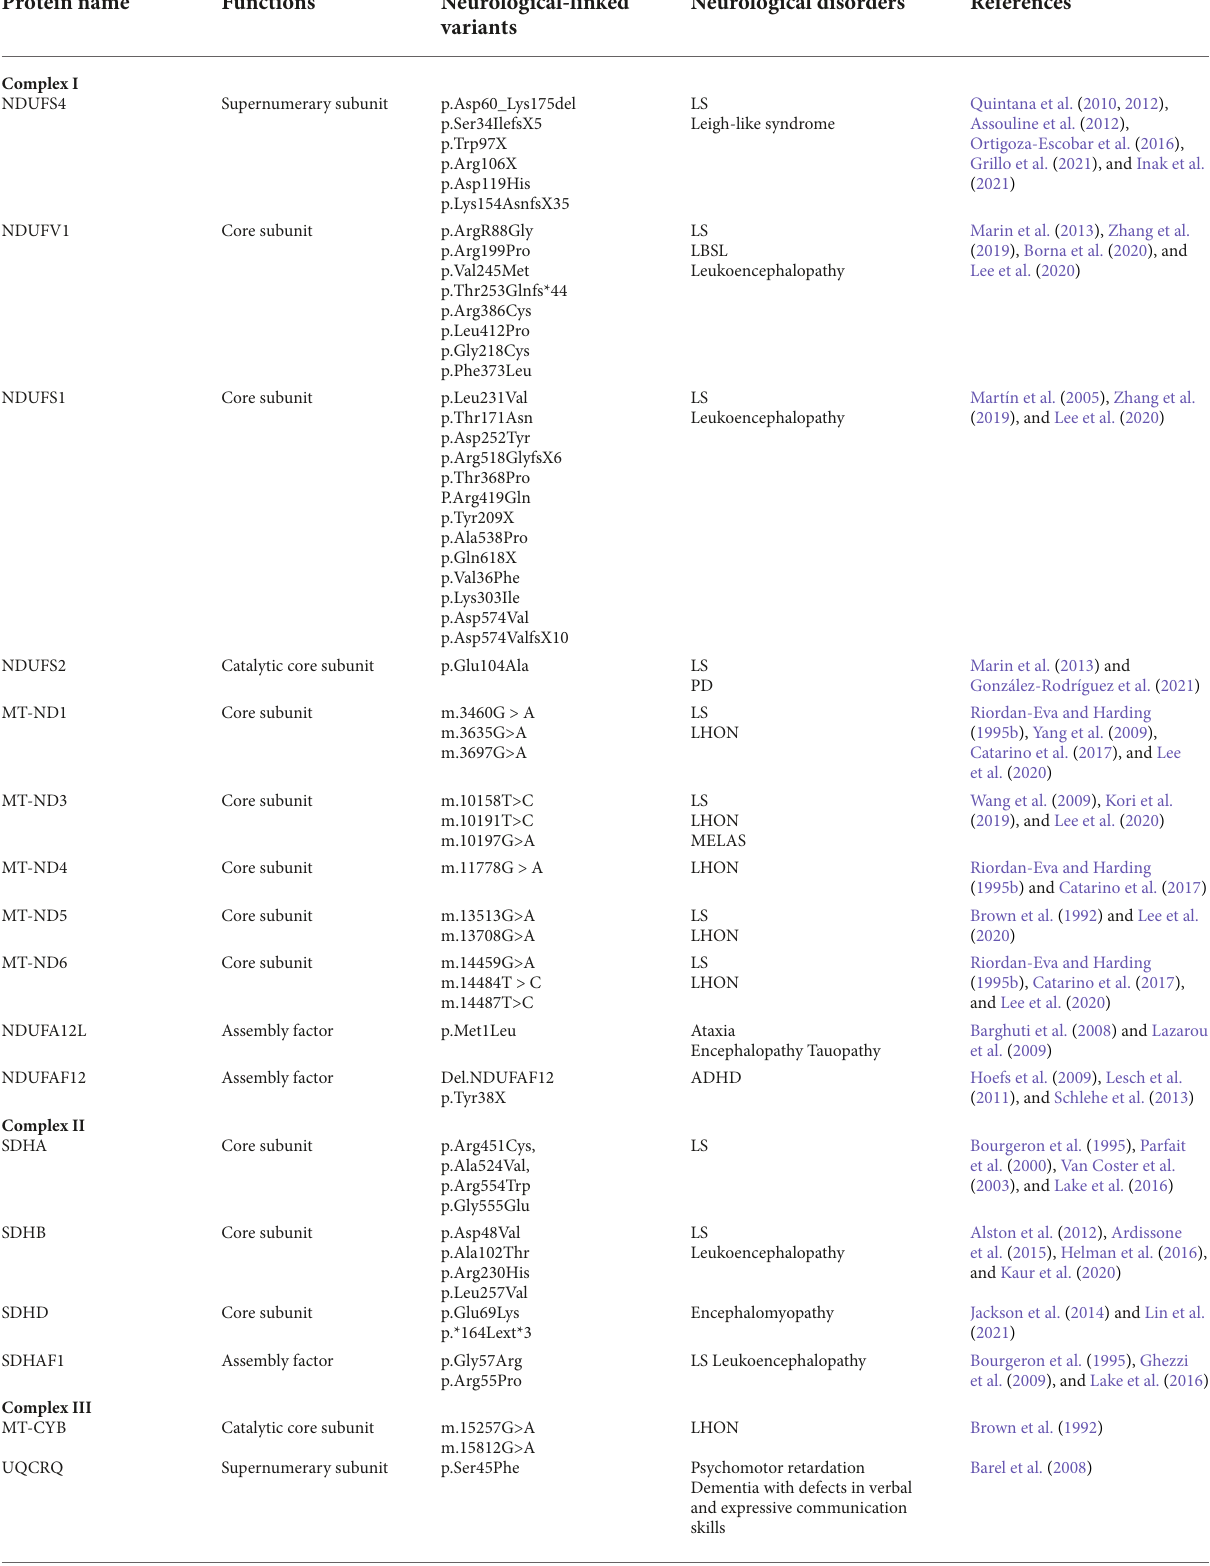
TABLE 1 Neurological diseases caused by protein variants involved in mitochondrial